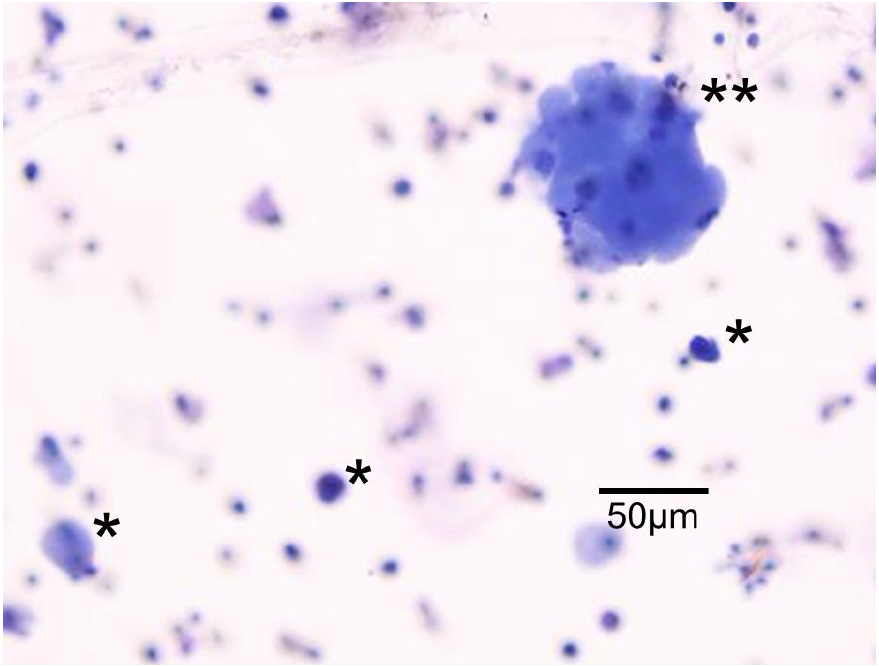
Figure 1. Circulating tumor cells (CTC) extracted with a CTC selection kit using a size selection method (ScreenCell ® CYTO Kit, Screen-Cell, Paris, France). *, singular CTC; **, clustered